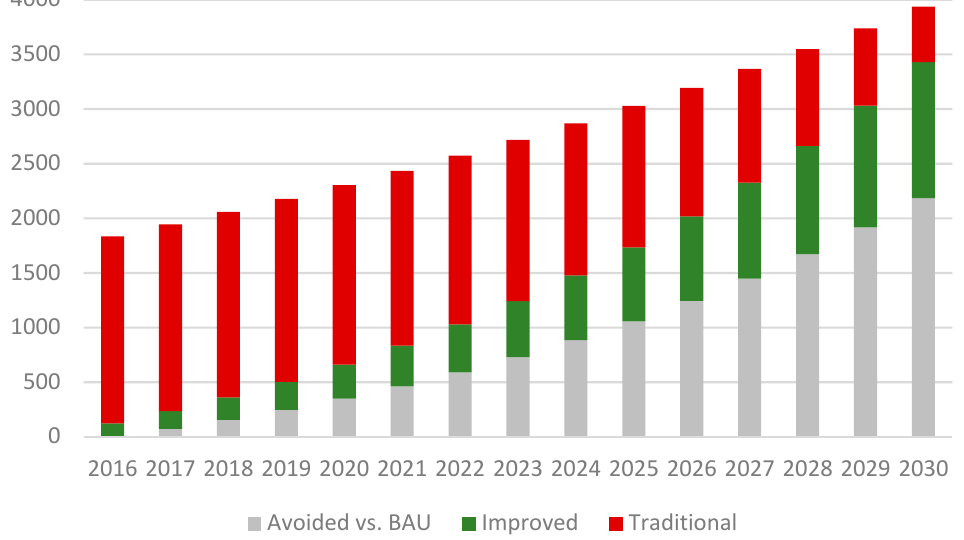
Figure 11. Firewood demand in the urban area according to the annual introduction of improved stoves until 2030. (Thousands of Barrel of Oil Equivalent per year).